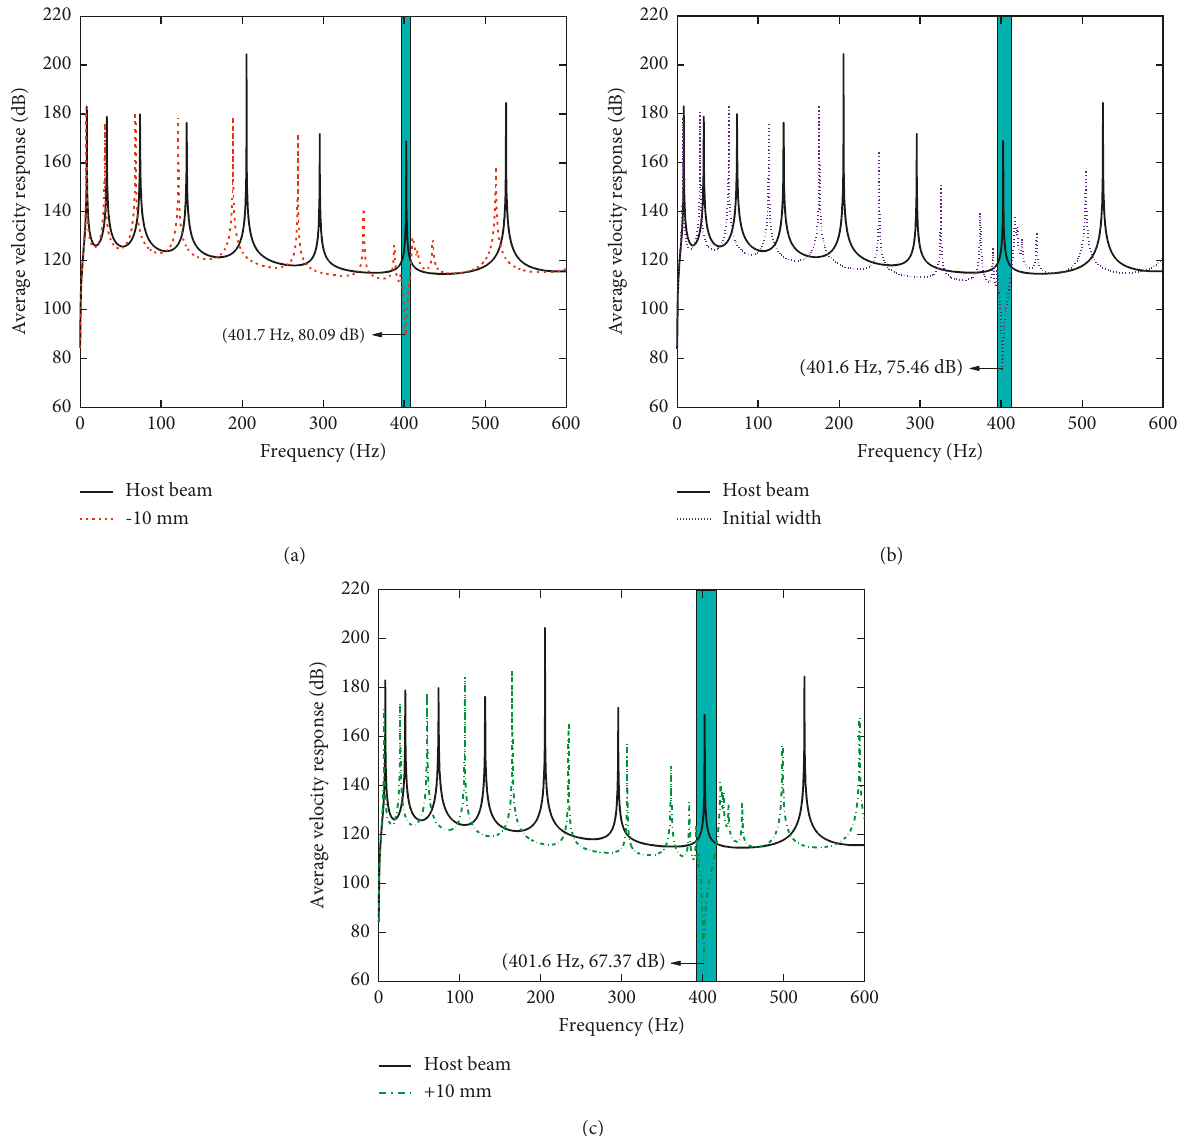
Figure 10: Influence of the beam-like resonator’s width on the vibration properties of the locally resonant beam.